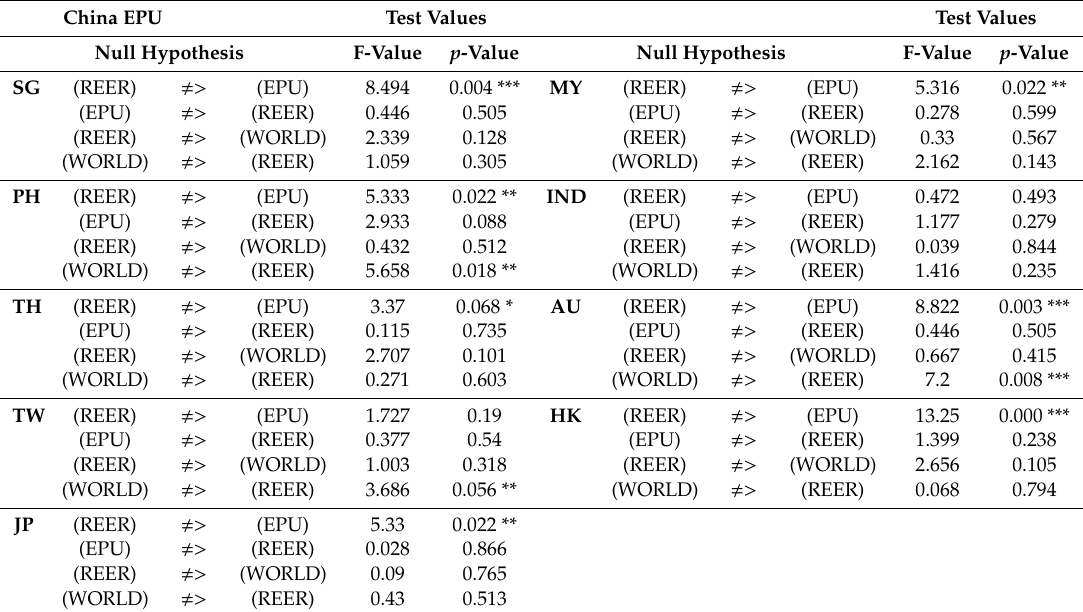
Table 9. Pairwise linear Granger-causality test between REERs and China EPU: January 1998–April 2017. China EPU Test